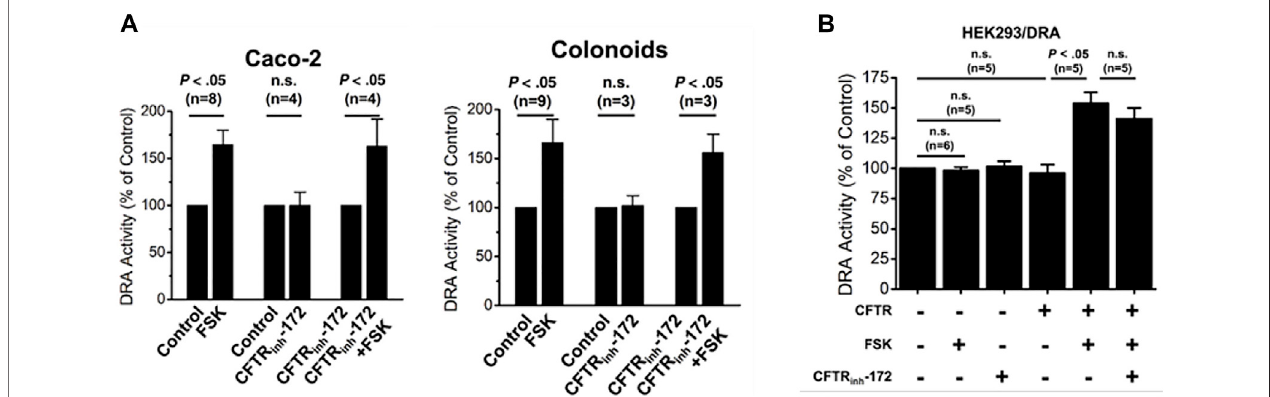
FIGURE 4 | CFTR presence but not activity is necessary for cAMP stimulation of DRA in Caco-2-BBe cells, human colonoids, and HEK cells. (A) . In both Caco-2- BBecellsandhumanproximalcolonoidmonolayers,bothcellsexpressCFTRandforskolin-stimulatedDRAactivitywhichwasnotinhibitedbytheCFTR inhibitor -172(from (Tse et al., 2019), Figs 8A and D, respectively). (B) . In HEK293 cells expressing DRA, forskolin (10 µM) stimulates DRA activity, but this only occurred when CFTR was expressed. This CFTR-dependent stimulation of DRA by cAMP was not altered by the CFTR inhibitor -172 (from (Tse et al., 2019), Figure 7A ).